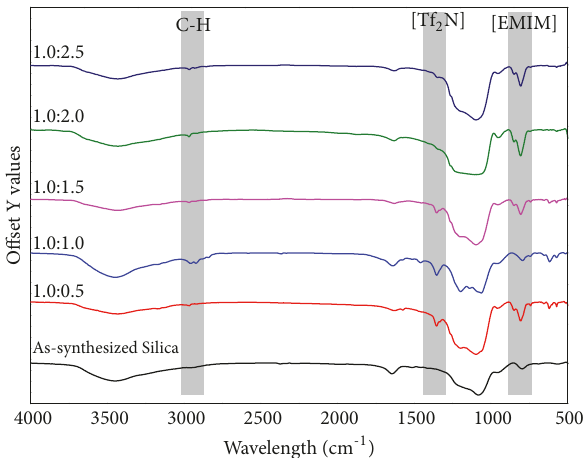
Figure 2: FTIR spectra of virgin silica and ionic liquid modified silica particles.